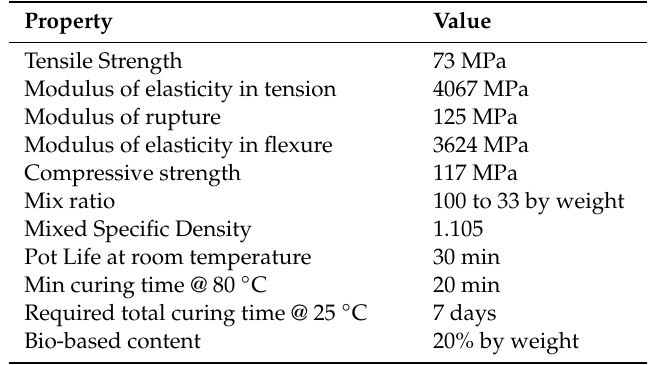
Table 1. Selected properties of epoxy-resin system investigated in this